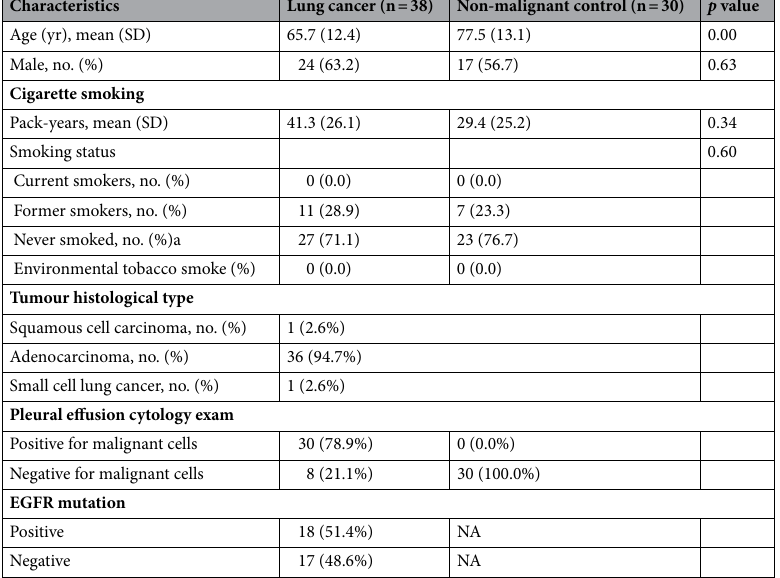
Table 1. Demographic characteristics of the study subjects with pleural effusion.